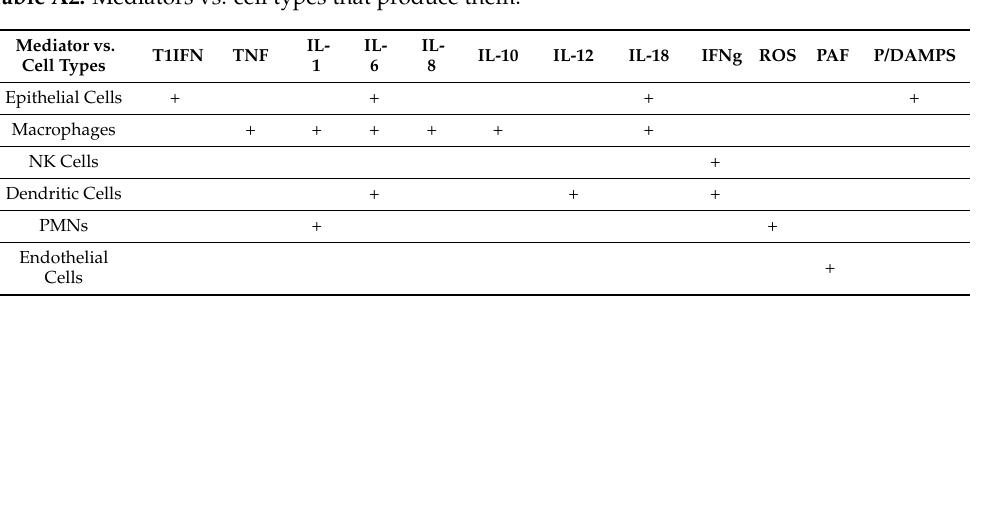
Table A2. Mediators vs. cell types that produce